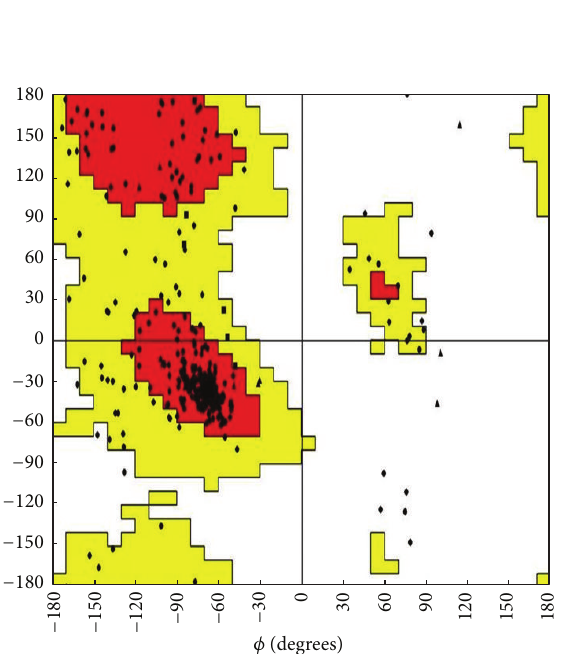
Figure 8: Ramachandran plot of modelled 5-HT dihedrals are 97.88% in allowed regions and 2.12% in disallowed